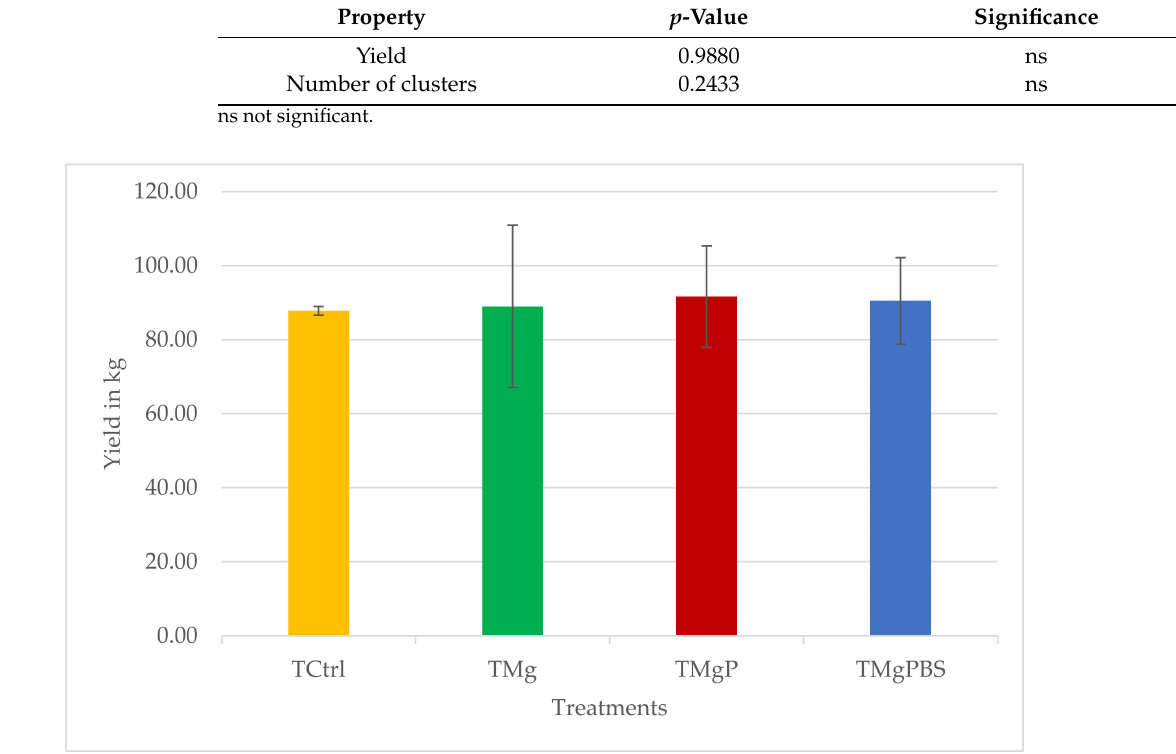
Figure 4. Yield in kg by treatment. (TCtrl—NPK, TMg—NPK + Agromag (6% MgO), TMgP—NPK +